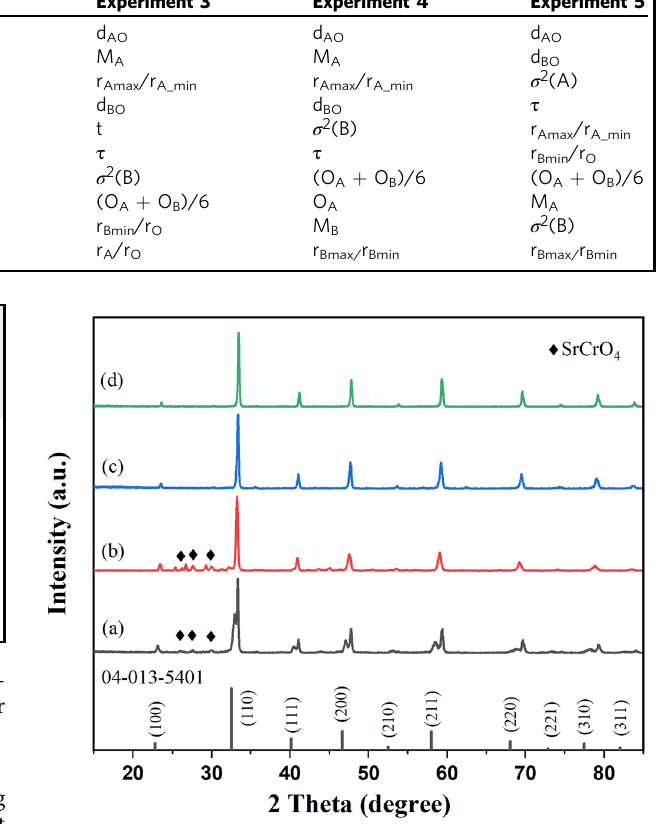
Fig. 4 XRD patterns of Sr 0.7 La 0.3 Cr 0.5 Mn 0.5 O 3 in different experimental conditions. a calcination at 1350 °C for 12 hours via the solid-state method, b calcination at 1100 °C for 16 hours via the modi fi ed Pechini method, c calcination at 1350 °C for 12 hours via the modi fi ed Pechini method, and d calcination at 1500 °C for 2 hours via the modi fi ed Pechini